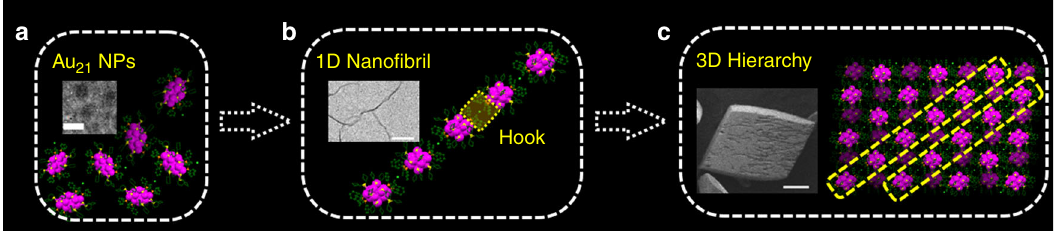
Fig. 1 Schematic diagram of the hierarchical fi brous (1D to 3D) assembly of Au 21 NPs. Inserted graphs are the transmission electron microscopic (TEM) image of individual Au 21 NPs in a (Scale bar: 2 nm); TEM image of the 1D nano fi bril assembled from Au 21 NPs in b (Scale bar: 50 nm); and the scanning electron microscopic (SEM) image of the 3D hierarchical crystals assembled from Au 21 NPs in c (Scale bar: 50 µ m). Magenta = Au, light green = Cl, yellow = S, orange = P, green = C; H atoms are omitted for clarity. The yellow rectangle in b indicates the surface hook. The yellow rectangles in c are the 1D motifs ( fi brils) in the 3D